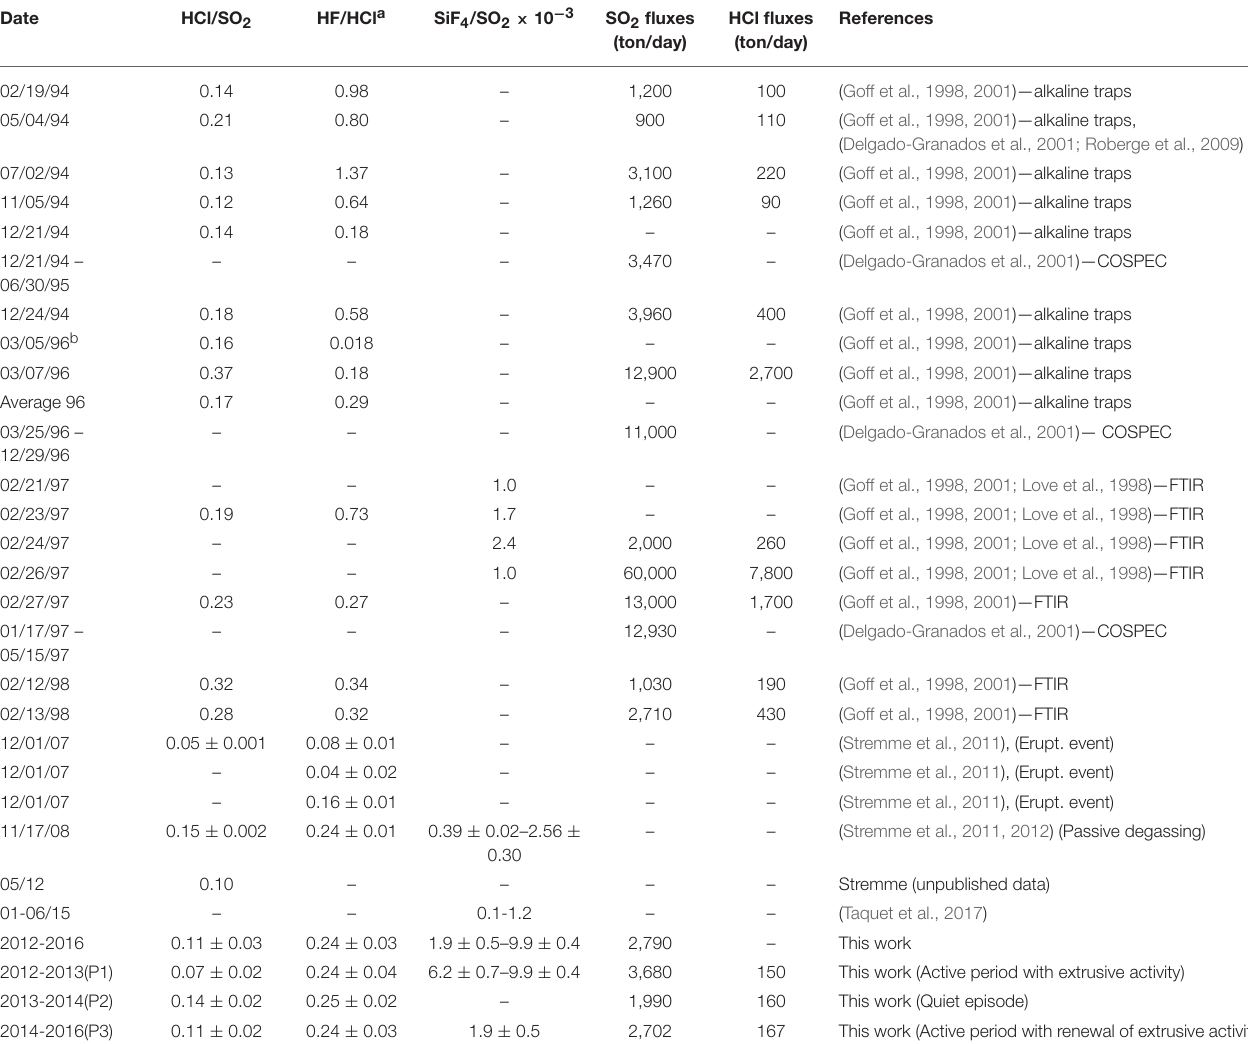
TABLE 3 | Previous measurements of the HCl/SO 2 , HF/HCl, SiF 4 /SO 2 ratios and SO 2 and HCl fluxes in the Popocatépetl